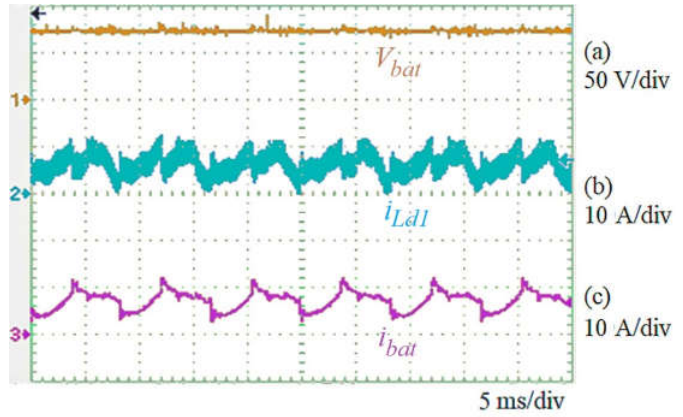
Figure 18. Experimental results for the proposed DIBC without the function of DAF: ( a ) voltage of the battery set; ( b ) inductor L d 1 current; ( c ) charging current of the battery set.